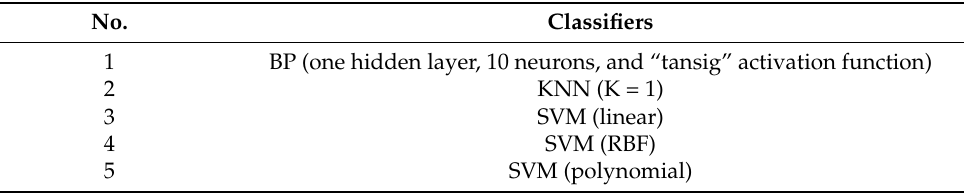
Table 5. The candidate base